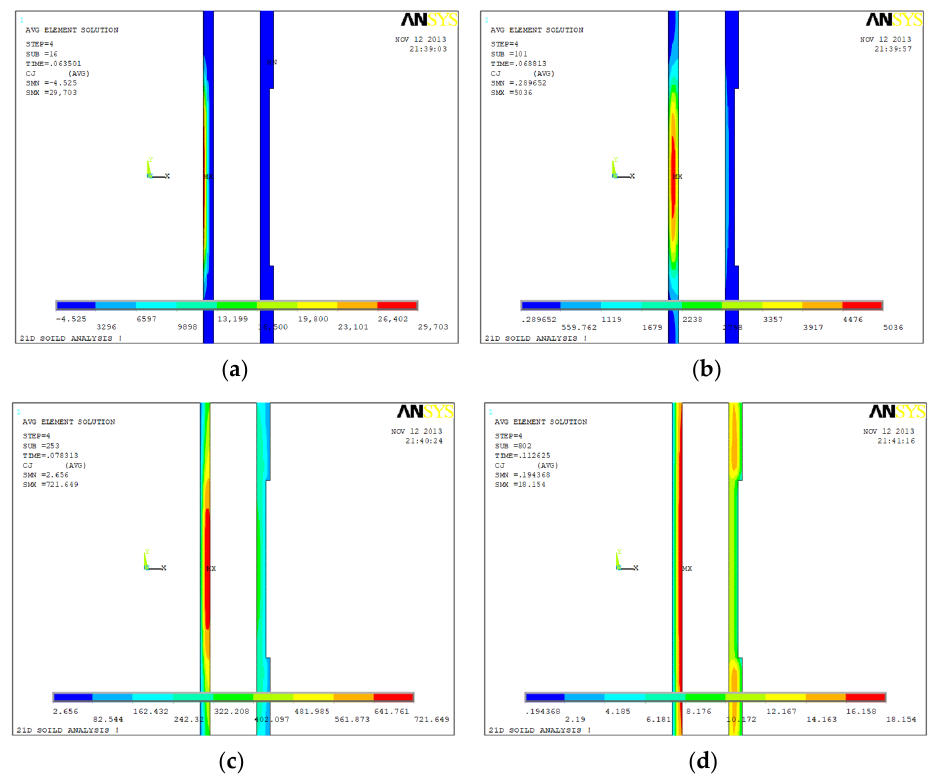
Figure 8. Eddy current distribution during power ‐ off time in the inspection for corroded casing plus undamaged tubing: ( a ) 0.0635 s (time slices Nos. 16); ( b ) 0.0688 s (time slices Nos. 22); ( c ) 0.0783 s (time slices Nos. 26); ( d ) 0.112 s (time slices Nos. 31).